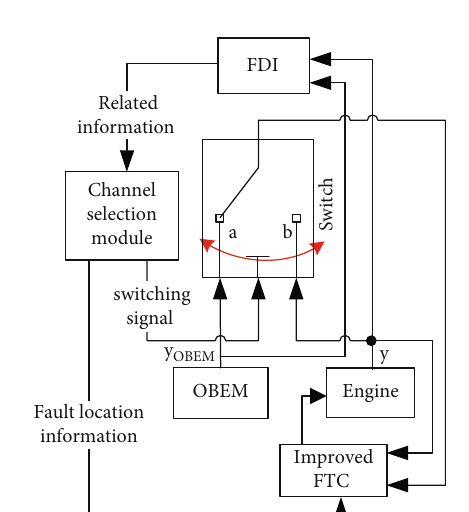
Figure 8: The calculation structure of the sensor WSSR.